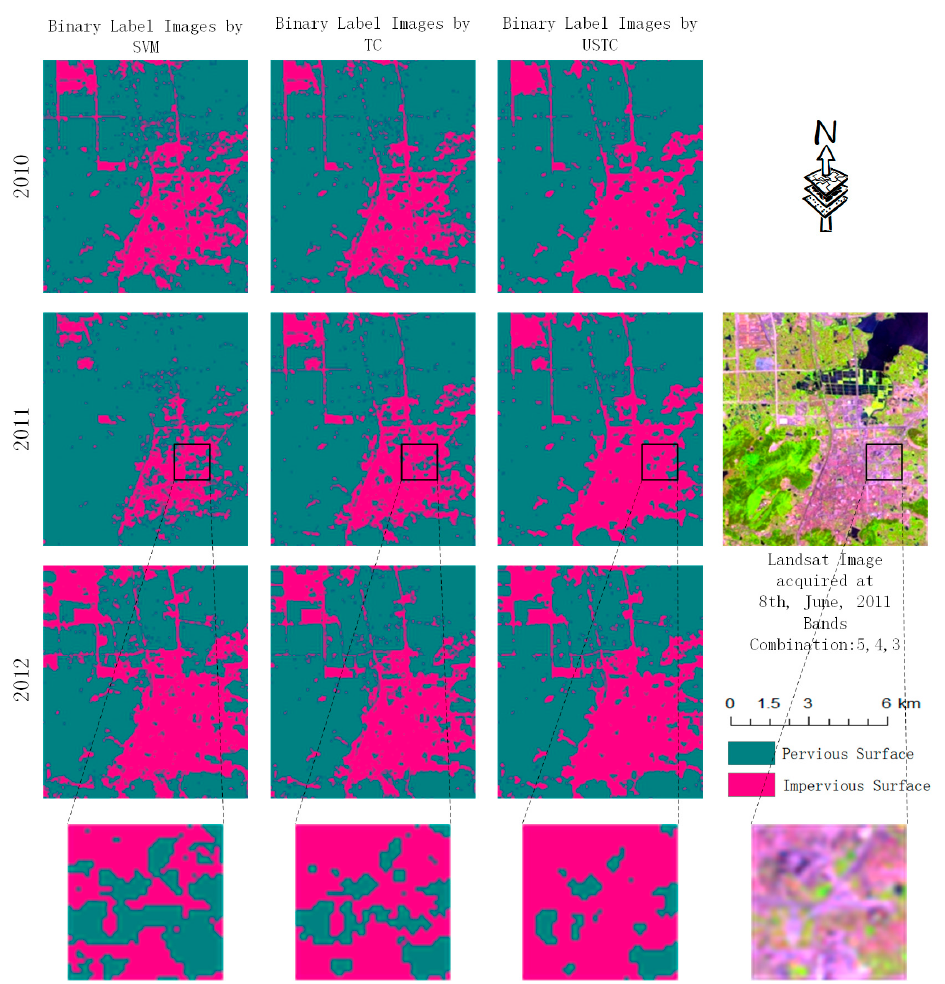
Figure 5. Comparison of three classification results in the main urban area of Jiangxia district, showing the underestimation case.